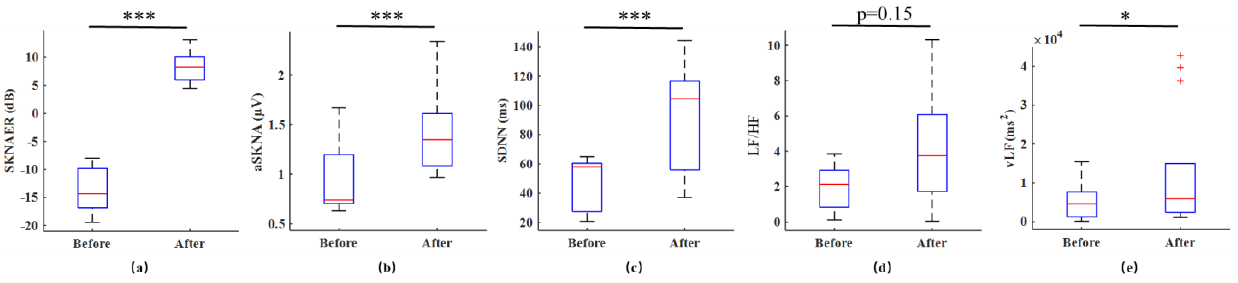
Figure 4. ( a – d ) The correlation between SKNAER and HRV features of the ten patients before and after sympathetic activation in Experiment 1.